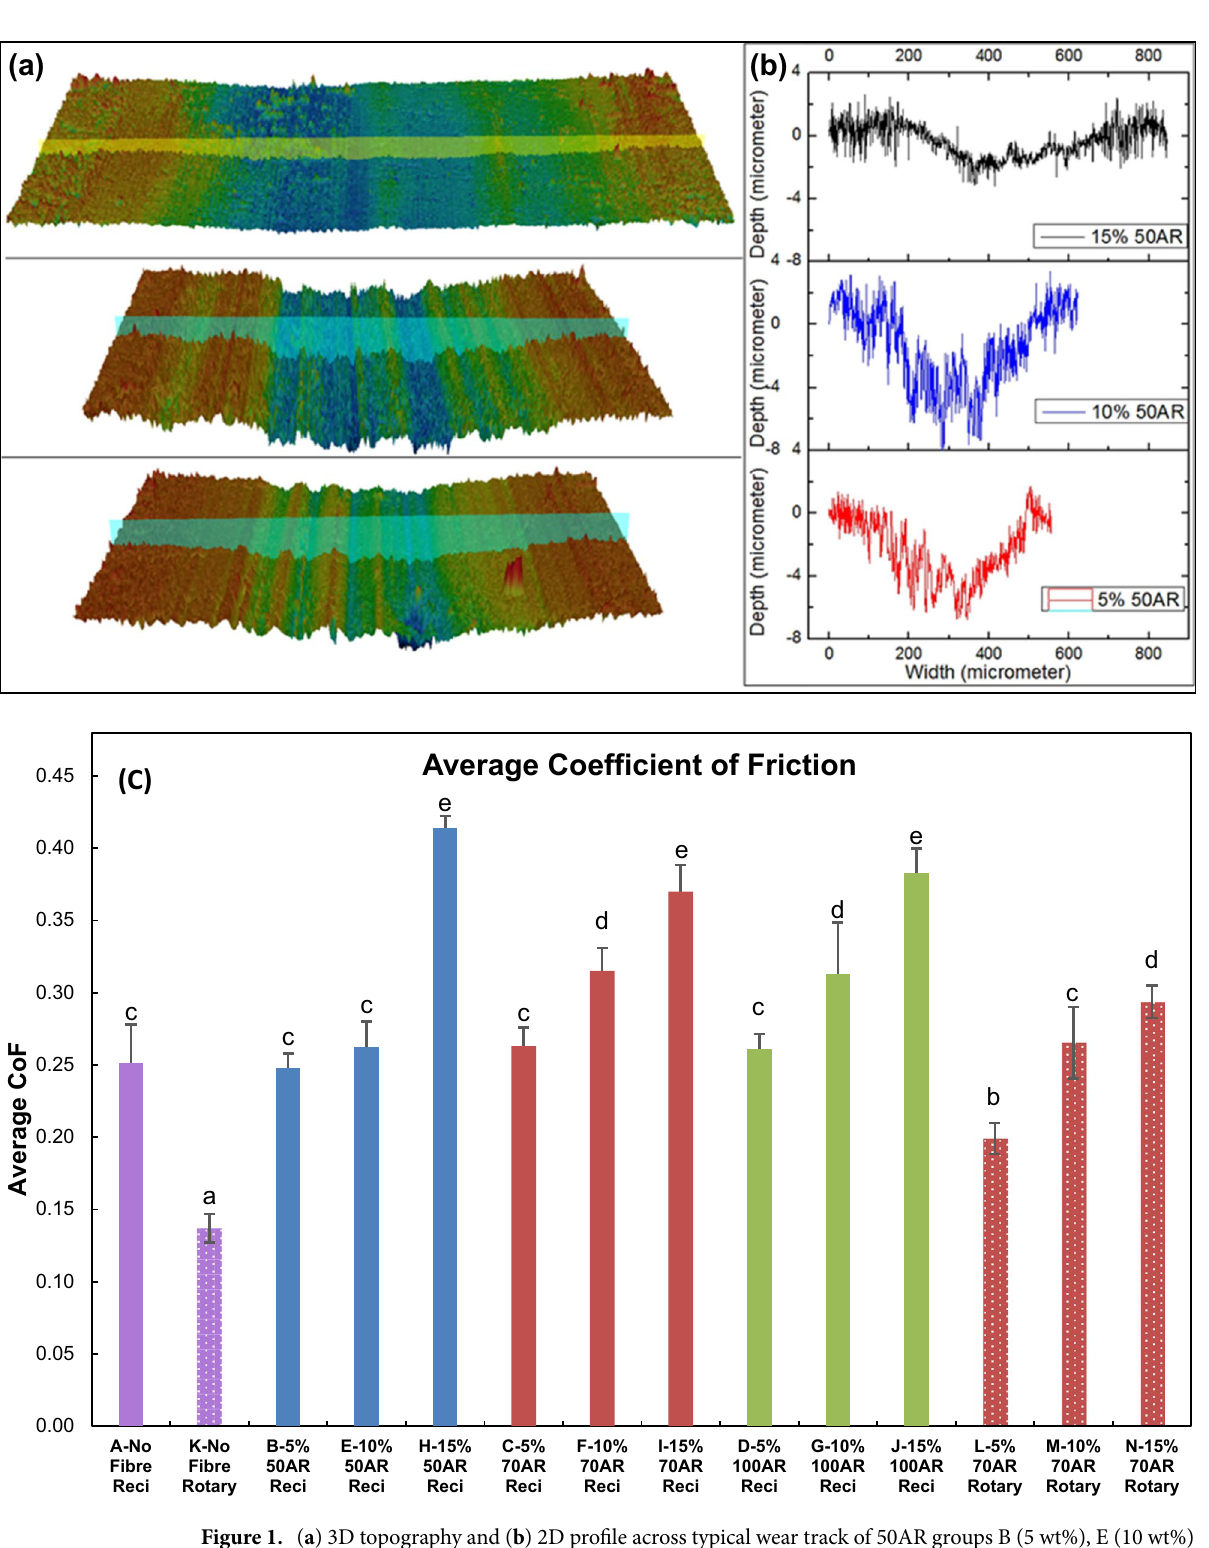
Figure 1. ( a ) 3D topography and ( b ) 2D profile across typical wear track of 50AR groups B (5 wt%), E (10 wt%) and H (15 wt%). ( c ) Average CoF for the reciprocating (Group A-J) and rotary tests (Group